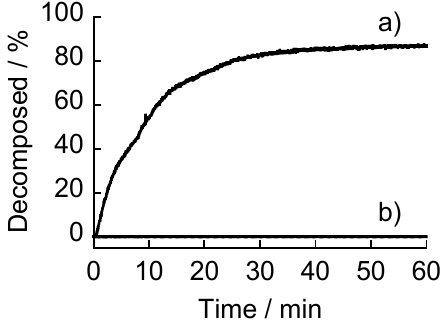
Figure 5. The kinetics of the decomposition of (CMC/39%PBA-PAMAM) 10 ( a ) and (AGA/39%PBA-PAMAM) 10 films ( b ) in buffer solution at pH 9.0.